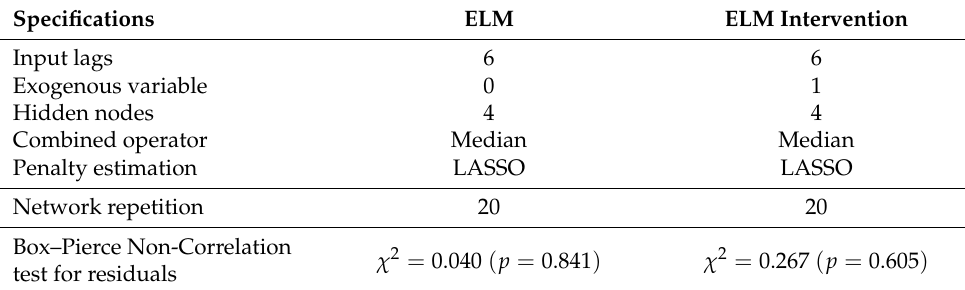
Table 5. ELM model and ELM intervention model parameter